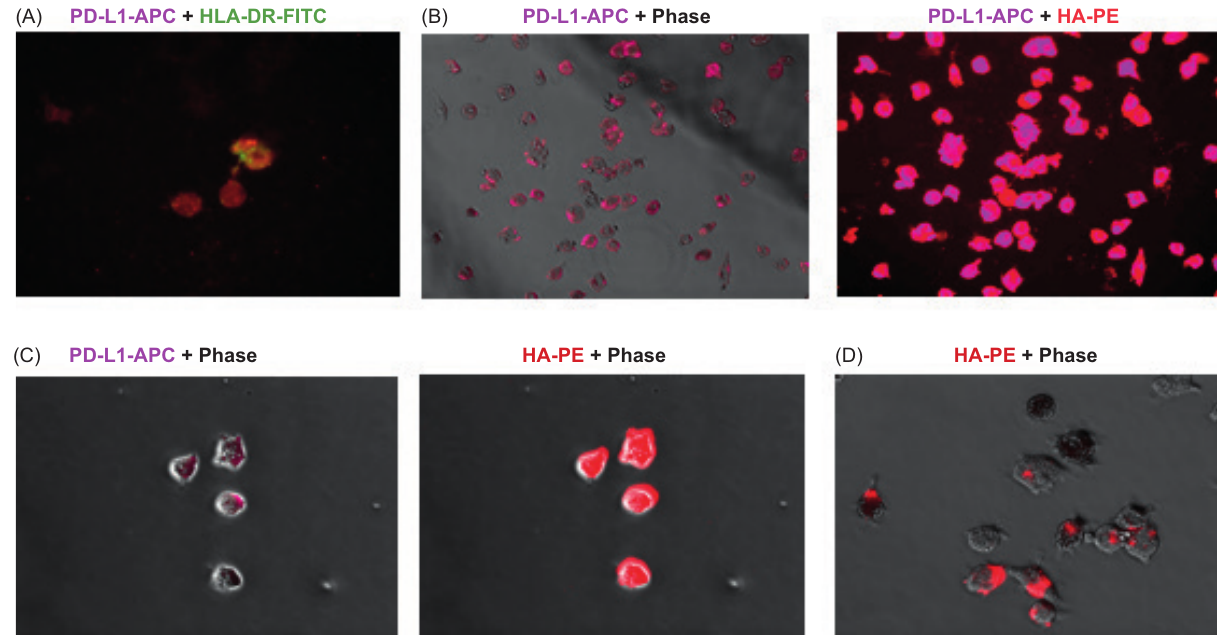
Figure 3: Visualization of intracellular HA in tumor-infiltrating PD-L1 + myeloid cells. The human cancer tissue slices were cultured for 7 days. Non-adherent cells were carefully removed from the plate. Plate with remaining adherent cells washed with PBS and fixed with 4% formaldehyde. Plate-bound cells were stained with HLA-DR-FITC (image A) and PD-L1-APC (images A, B, C) antibodies. To visualize the tumor-produced HA, biotinylated HA-binding protein and PE-labeled Streptavidin were subsequently added (images B, C, D). Representative images are